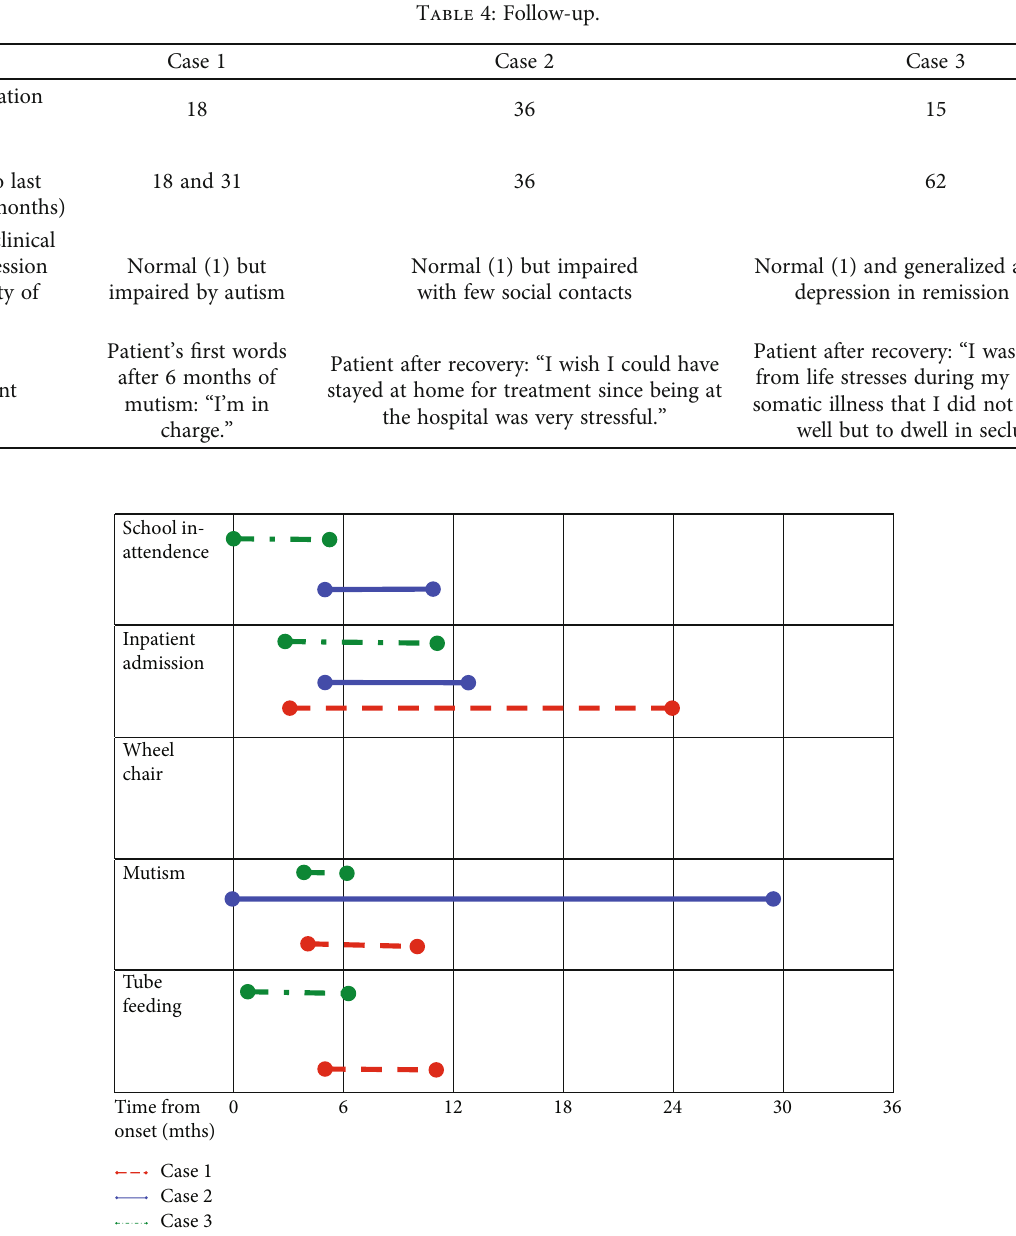
Figure 1: Timeline from onset to functional